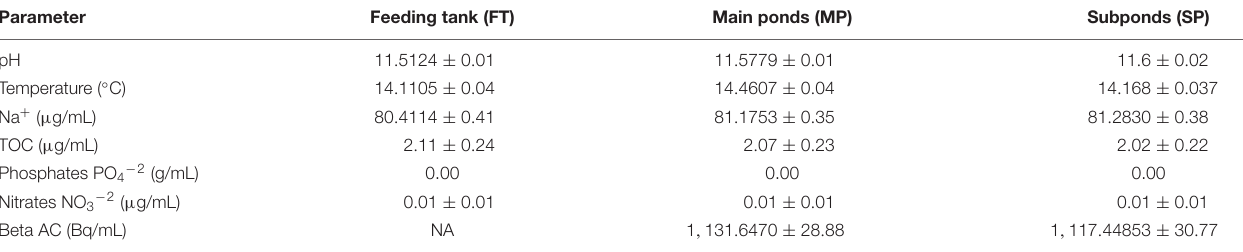
TABLE 2 | Parameters measured in the indoor alkaline spent fuel storage pond